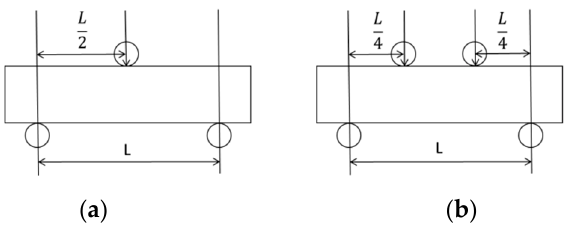
Figure 2. Schemes of ( a ) three-point bending test; ( b ) four-point bending test. Schemes were adapted from reference [47] . Reproduced with permission from Chitchumnong, P.; Brooks, S. C.; Stafford, G. D.; Dental Materials; published by Elsevier, 1989.